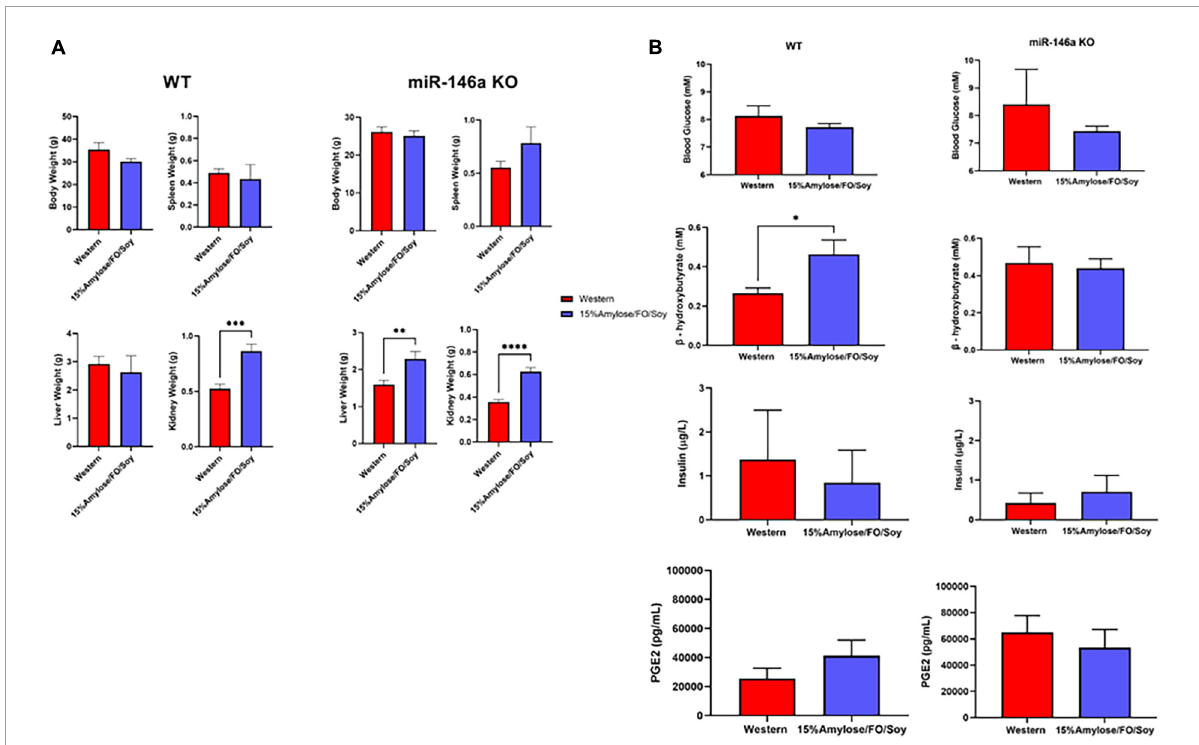
FIGURE3 A 15%Amylose/Soy/FO diet reveals only minor differences with a Western diet when miR-146a KO or WT mice are compared at their humane endpoints. (A) A comparison of the body, spleen, liver and kidney weights of both WT mice on a Western ( n = 10) vs. a 15%Amylose/Soy/FO ( n = 10) diet and miR-146a KO mice on a Western ( n = 15) vs. a 15%Amylose/Soy/FO ( n = 15) diet when the mice reached their humane endpoint. (B) Blood glucose, insulin, β -HB and PGE 2 levels of both WT mice on a Western ( n = 10) vs. a 15%Amylose/Soy/FO ( n = 10) diet and miR-146a KO mice on a Western ( n = 15) vs. a 15%Amylose/Soy/FO ( n = 15) diet when the mice were within 1 month of their humane endpoint. The data are shown as the mean ± SEM. ∗ P < 0.05, ∗∗ P < 0.01, ∗∗∗∗ P <